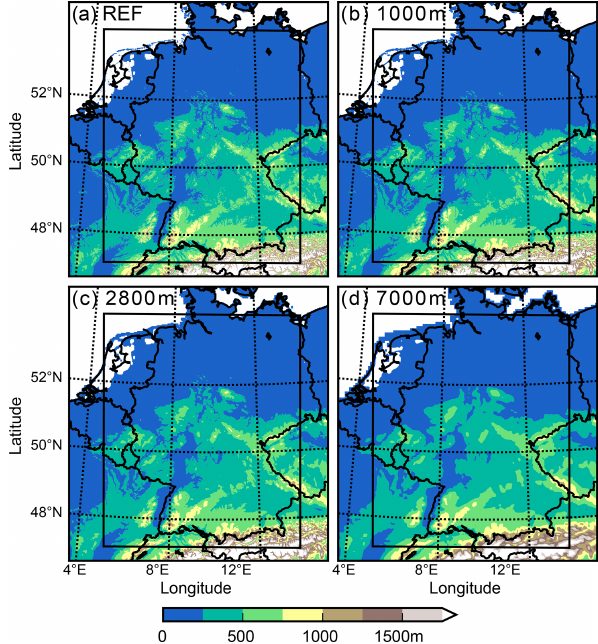
Figure 1. Reference orography at 500m grid spacing (a) and inter- polated orography from 1km (b) , 2.8km (c) , and 7km (d) to the model grid. The black rectangle depicts the 500m simulation do-